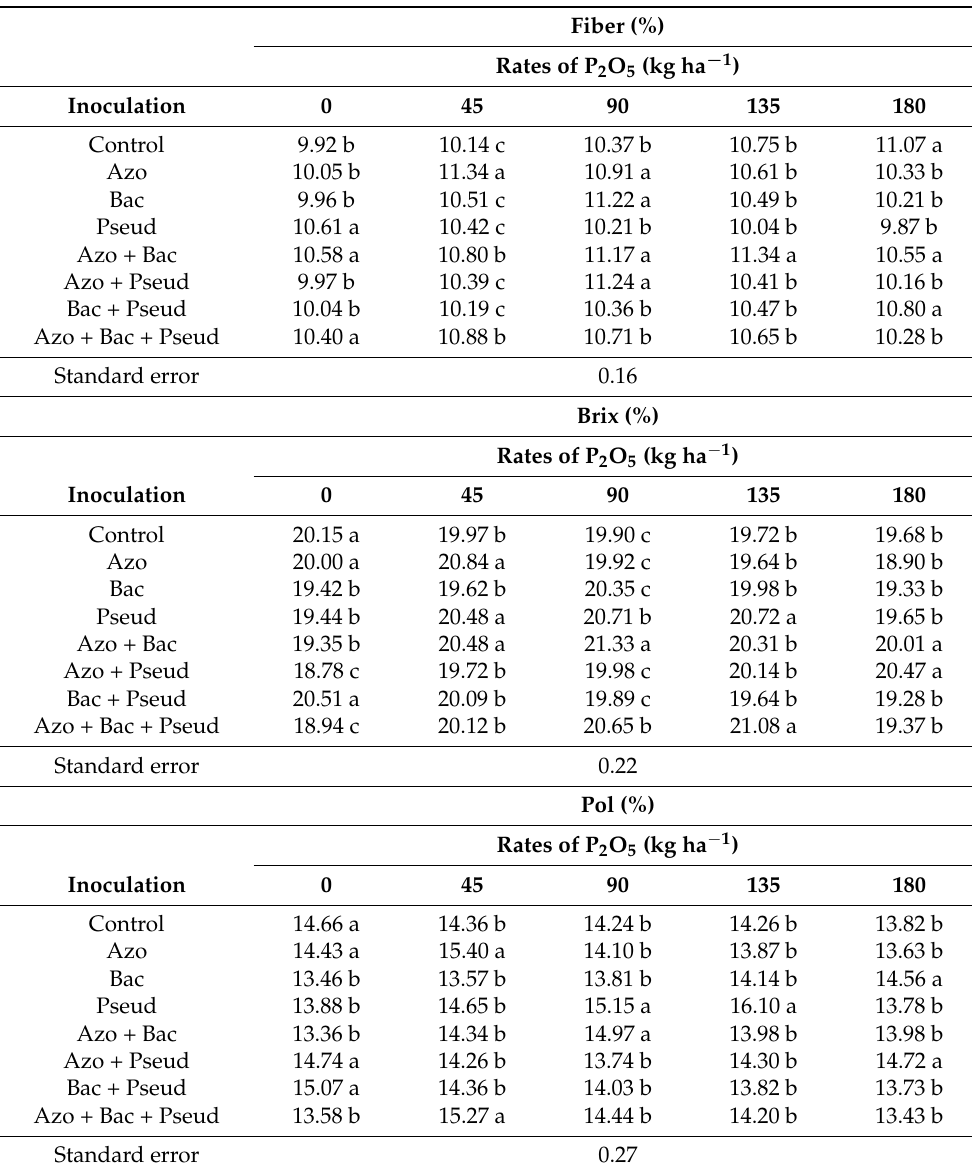
Table 4. Interaction of inoculation and P 2 O 5 rates for fiber, Brix and pol in RB92579 sugarcane